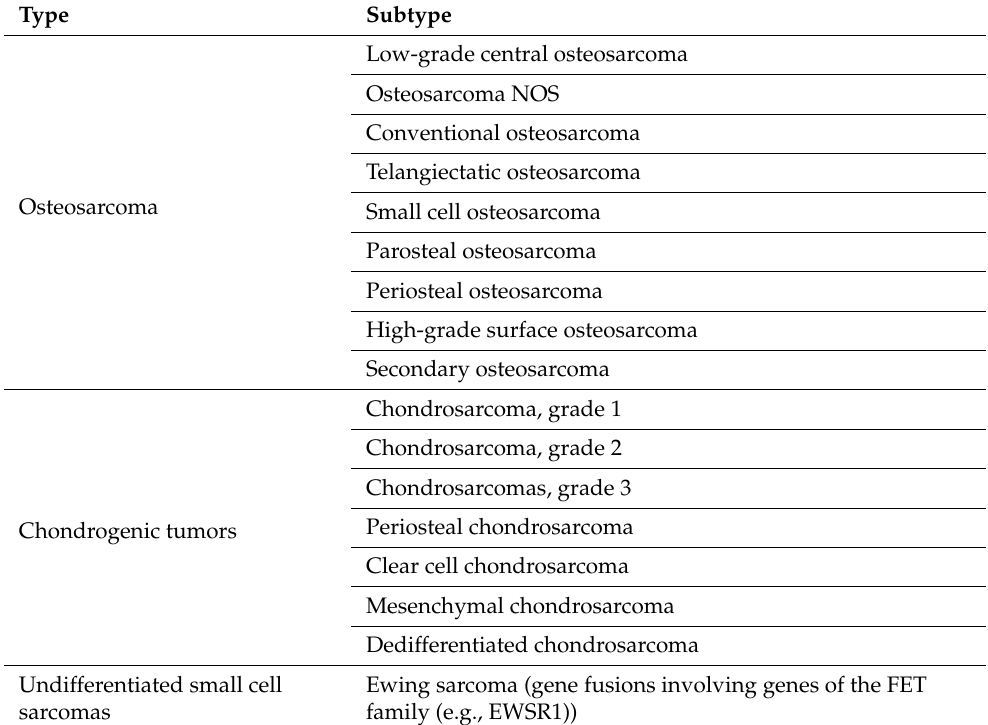
Table 1. The WHO classification of malignant chondrogenic and osteogenic as well as Ewing sarcomas